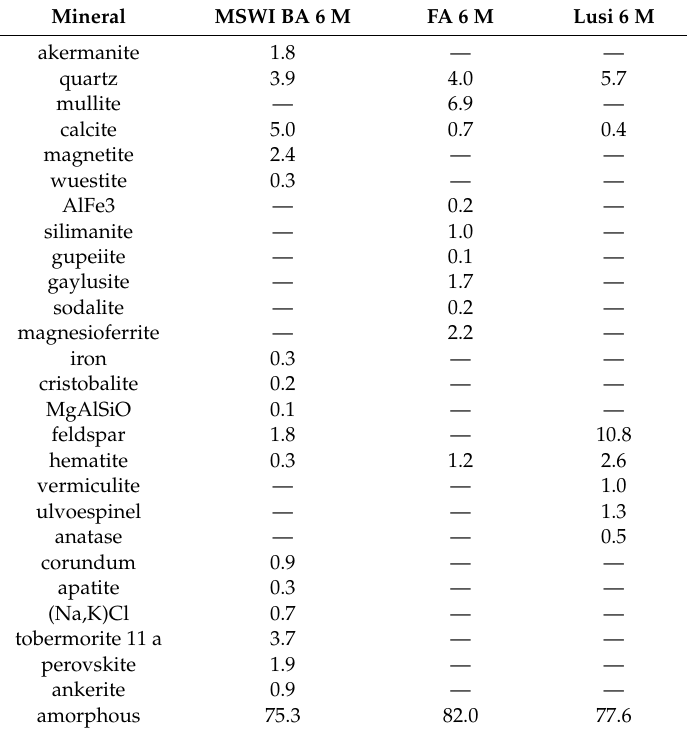
Table 6. Mineralogy of MSWI BA 6 M, FA 6 M, and Lusi 6 M